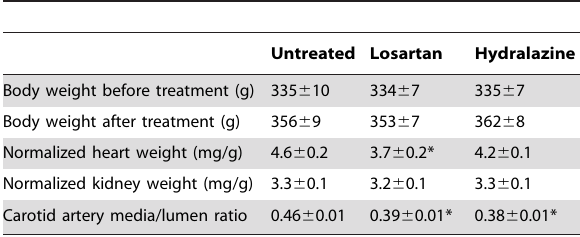
Table 1. General characteristics of treated and untreated spontaneously hypertensive rats.